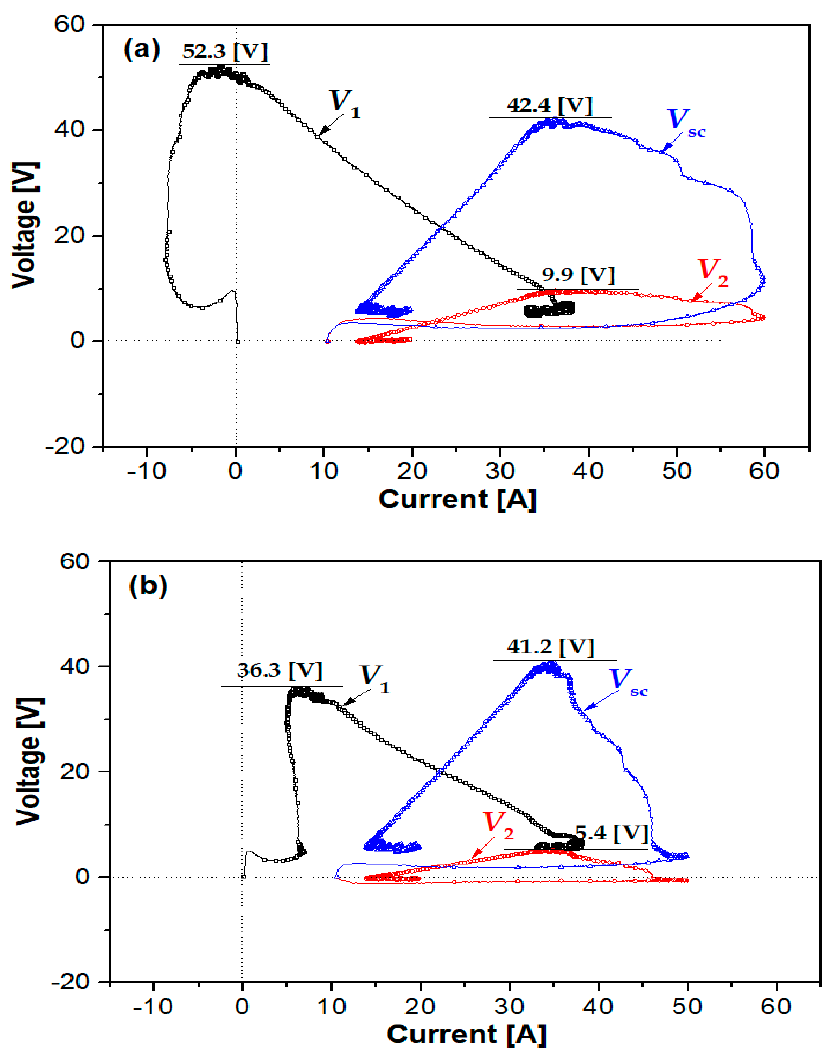
Figure 9. Voltage and current trajectories in each device of the flux-coupled type SFCL during the fault: ( a ) for the additive wiring; ( b ) for the subtractive wiring.